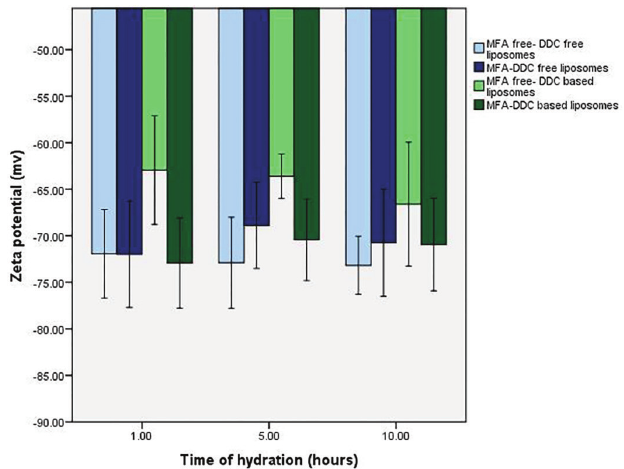
FIGURE 6 - Zeta potential (mv) when different liposomal components and duration of hydration